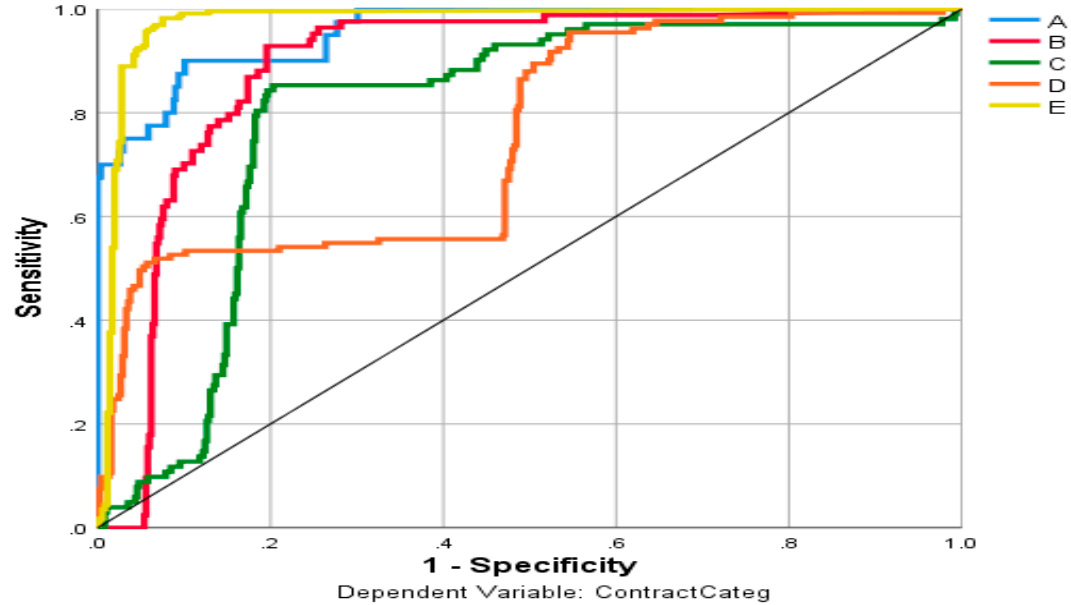
Figure 3. ROC curve for the ContractCateg variable.